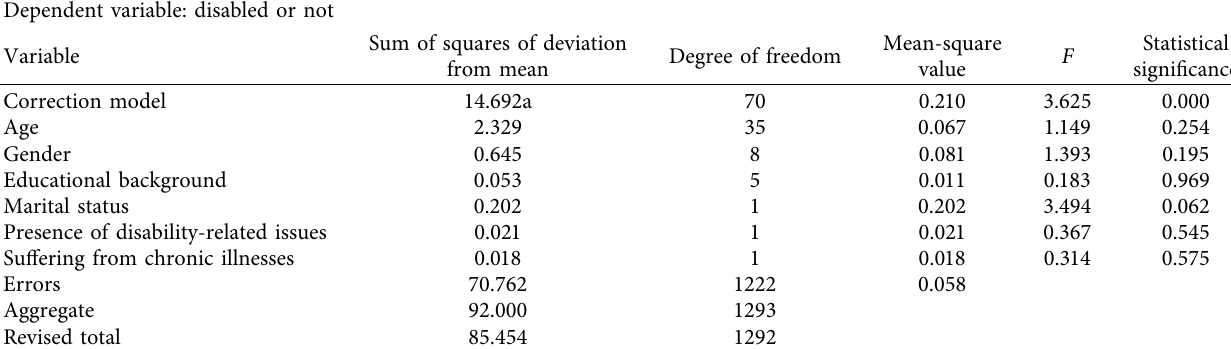
Table 2: Results from the multifactor analysis of variance.